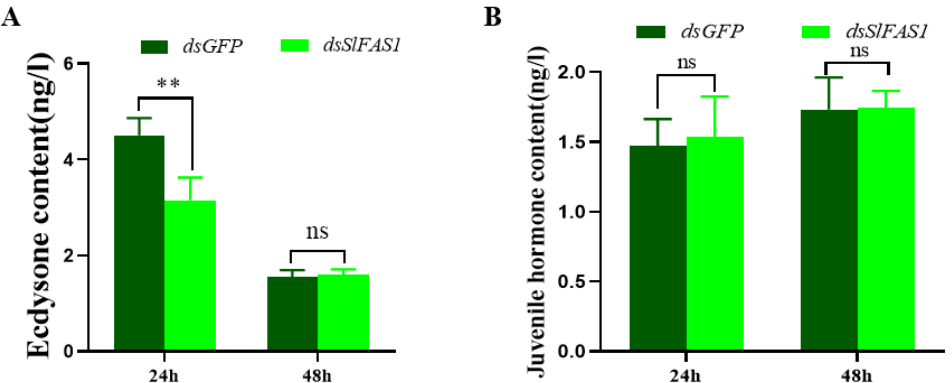
Figure 9. Effect of knocking down SlFAS1 on the content of juvenile hormone and ecdysone in the haemolymph of fifth instar larvae. ( A ) Effect of silencing SlFAS1 on ecdysone content in the haemolymph of fifth S. litura larvae. ( B ) Effect of silencing SlFAS1 on juvenile hormone content in the haemolymph of fifth instar S. litura larvae. Significant differences were compared using a one-way analysis of variance (ANOVA). Significant differences were indicated by asterisks (** p < 0.01; ns, no significant differences).